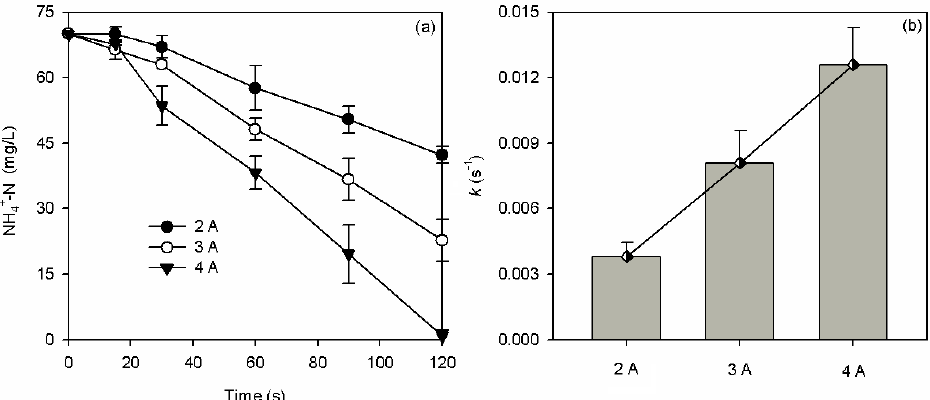
Figure 1. ( a ) NH 4+ -N concentration evolution and ( b ) k of NH 4+ -N removal during the electrochem- istry treatment of the spent caustic wastewater with varying currents.